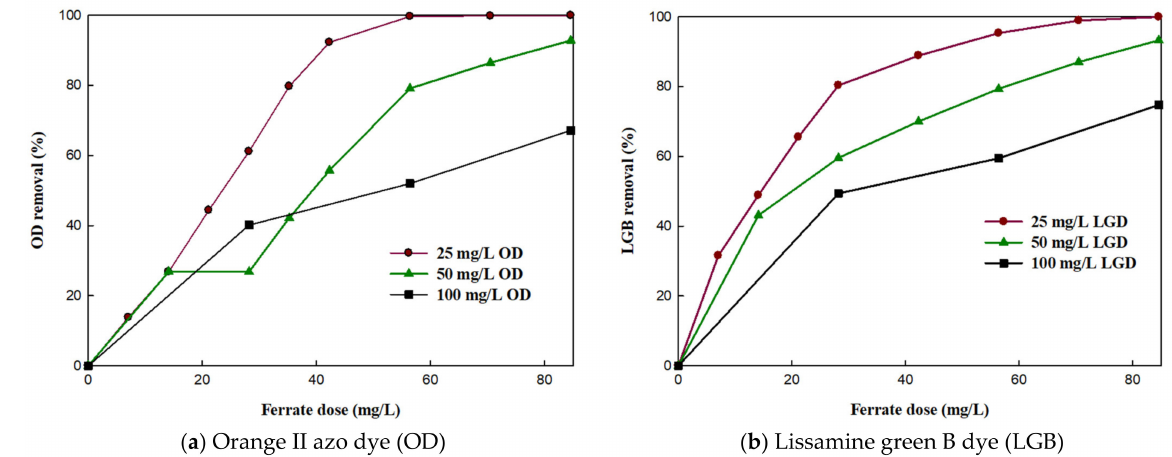
Figure 3. Effect of potassium ferrate dose on the removal efficiency of ( a ) orange II azo dye ( b ) and lissamine green B